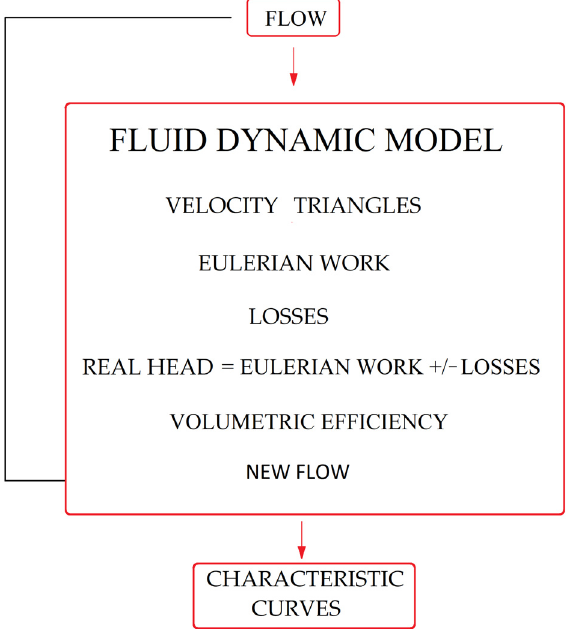
Figure 1. Flow chart summarizing the main steps of the development.